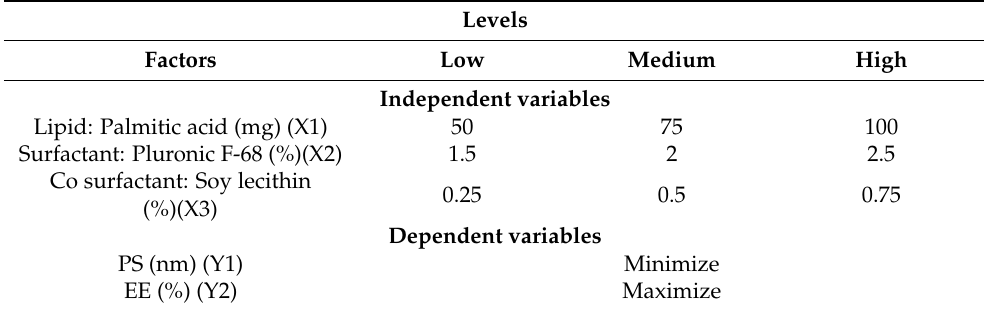
Table 2. Dependent and Independent variables for BBD model of DATS-SLNs. Levels Factors Low Medium High Independent